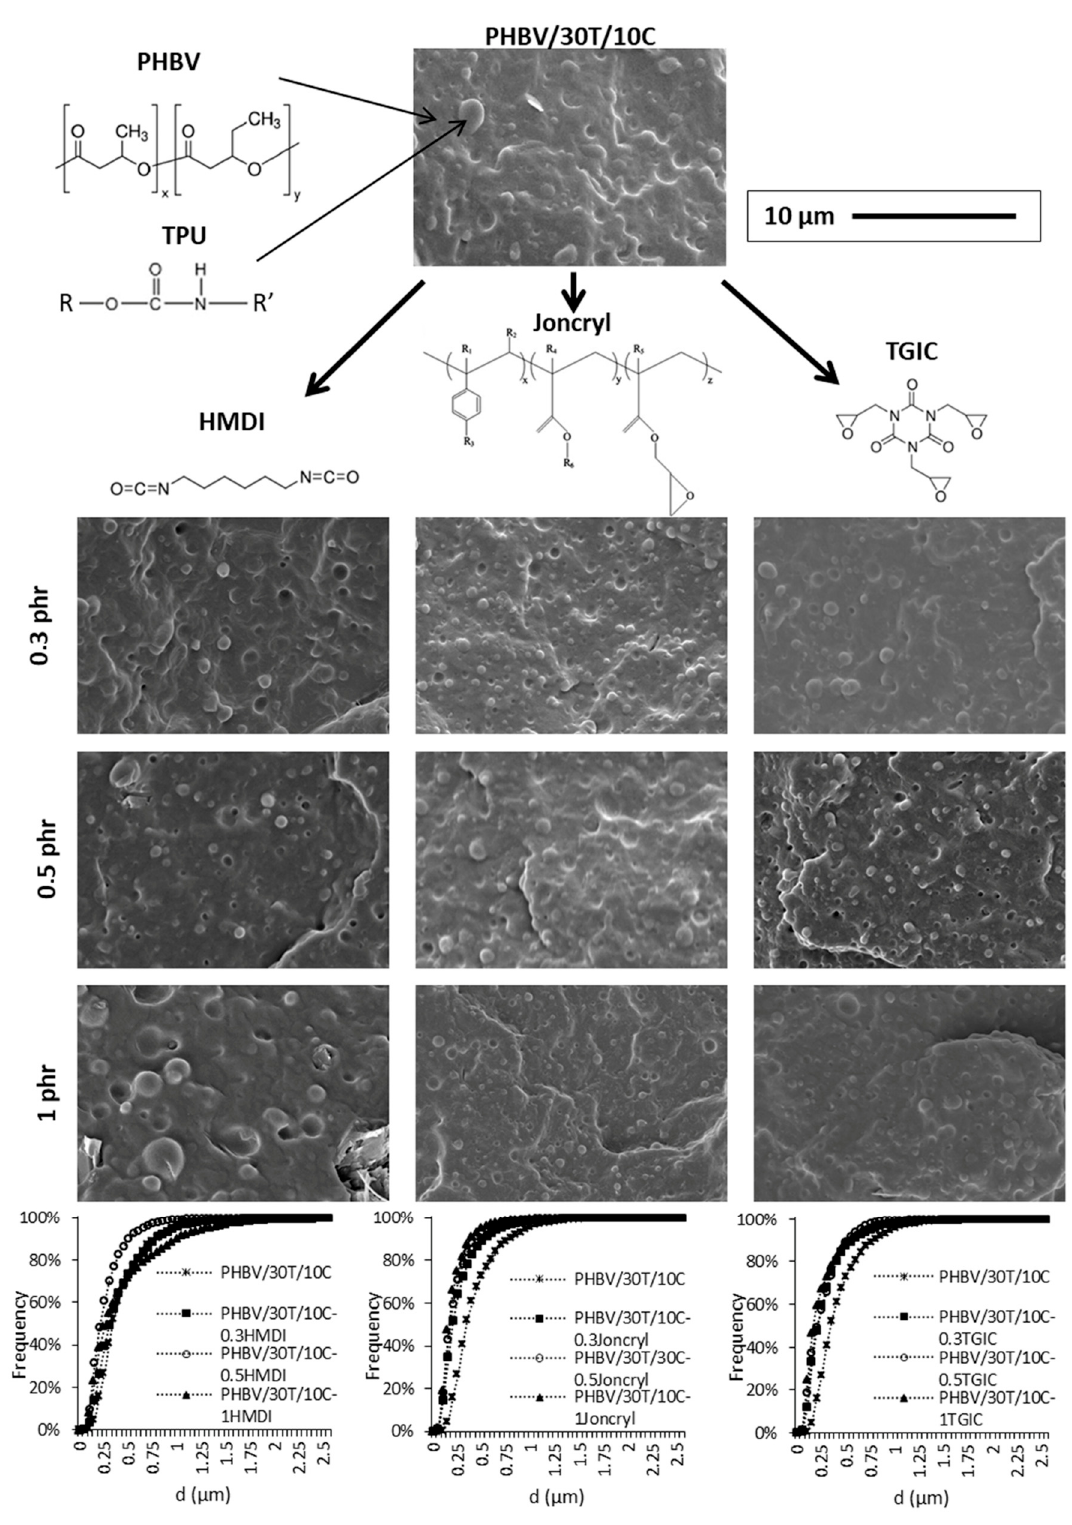
Figure 5. SEM images of the PHBV/30T/10C composites with the different reactive agents and cumulative frequency droplet size histograms of the dispersed phase.